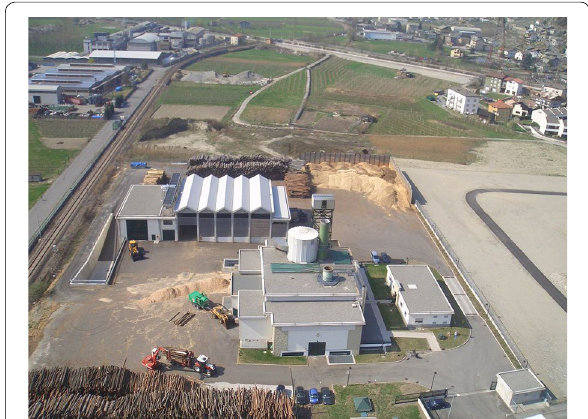
Fig. 8 Biomass district heating plant of Tirano (Source: Alta Rezia